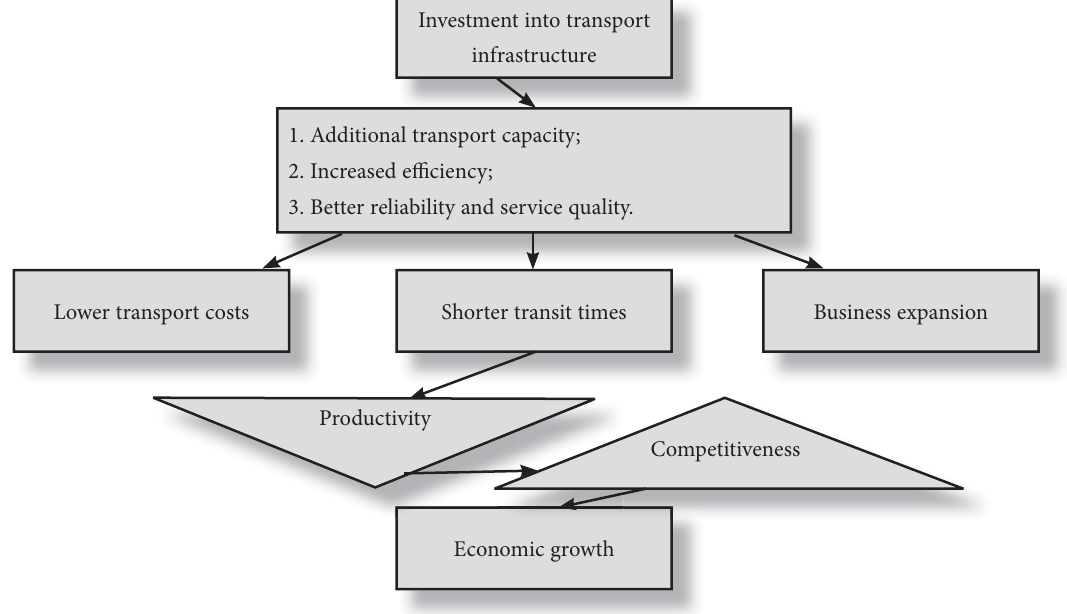
Fig. 1. Th e impact of transport on economic